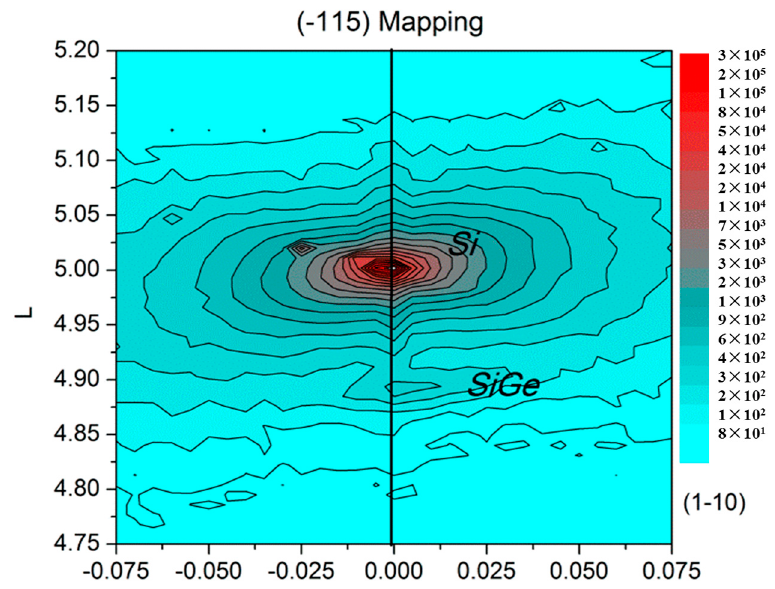
Figure 10. HRRLM at ( − 115) reflection from 14 nm FinFETs arrays with of SiGe in S/D areas. Reproduced with permission from [50]. Copyright Solid-State Electron, 2016.